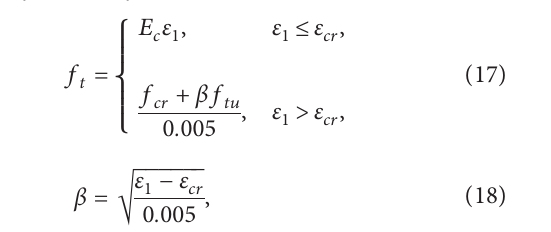
Figure 5: Tensile constitutive model of UHPC in the biaxial stress